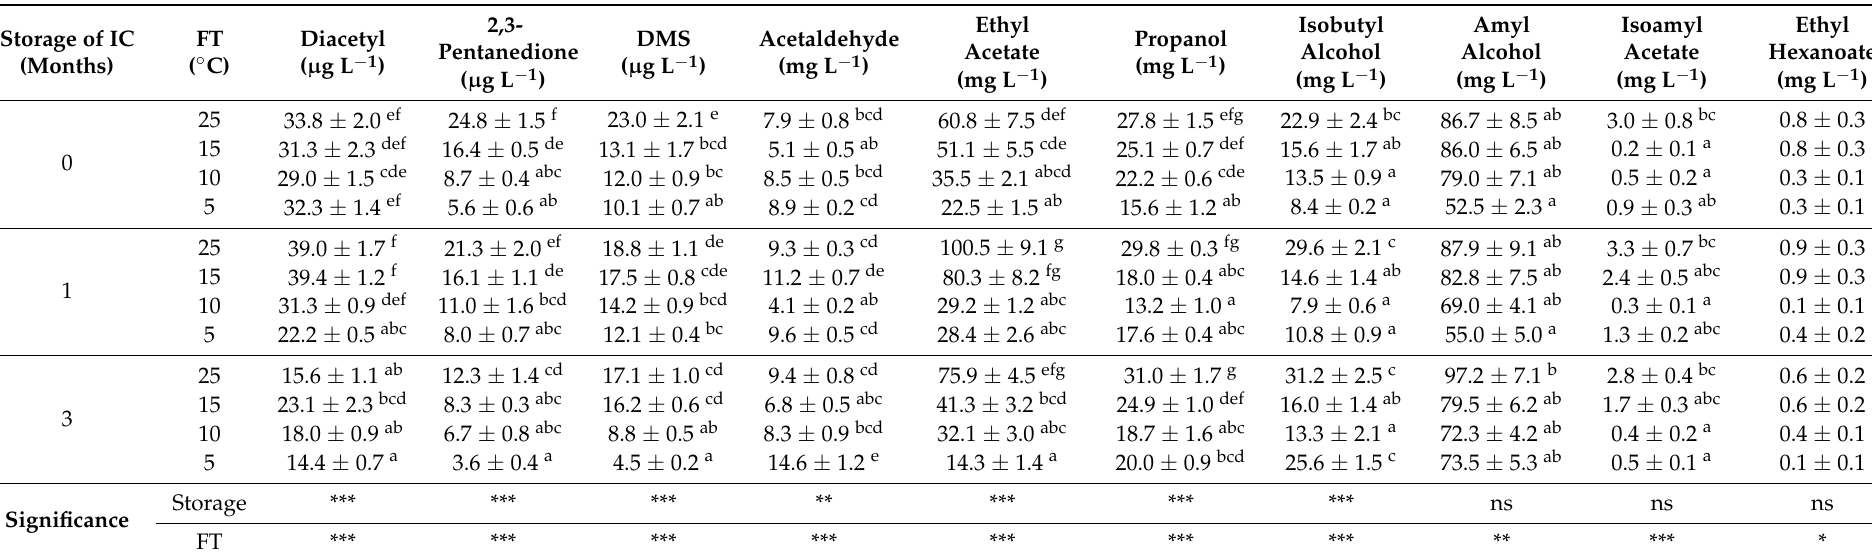
Table 1. Major volatile compounds in beers produced using thermally dried immobilized S. cerevisiae on coconut